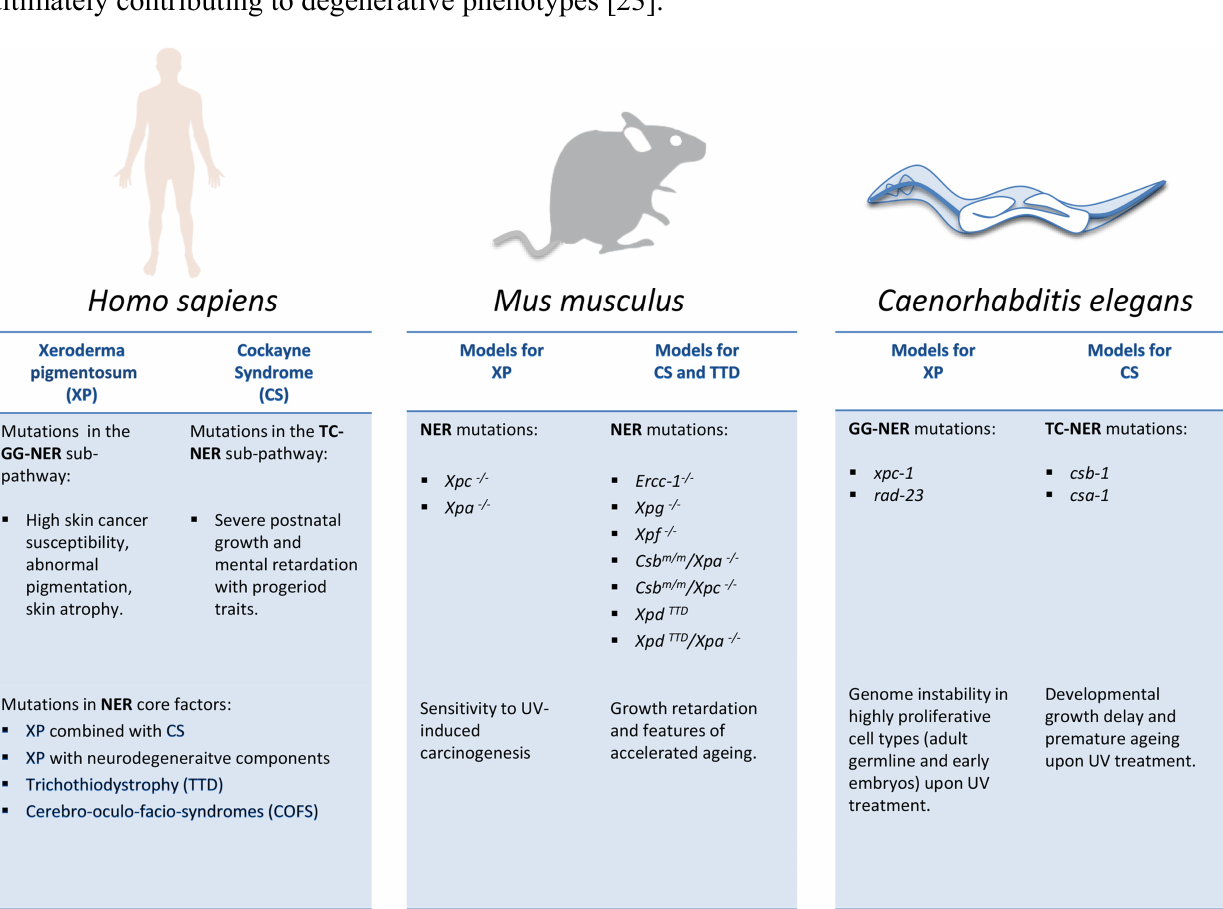
Figure 2. NER mutations in cancer susceptibility, developmental failure, and premature aging. Comparison of distinct consequences of NER mutations in human patients and NER models in mice and C . elegans . Note that in contrast to human patients, genetic inactivation of GG-NER (e.g., Xpc ) or TC-NER ( Csb or Csa ) genes alone in mice have